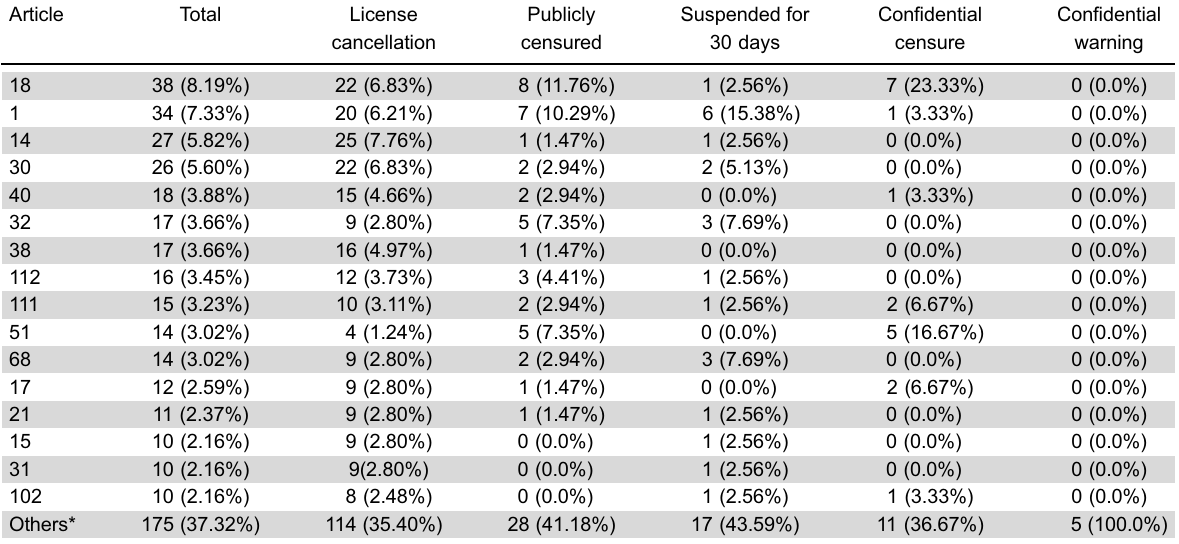
Table 4. Articles of the 2009 medical code of ethics that were